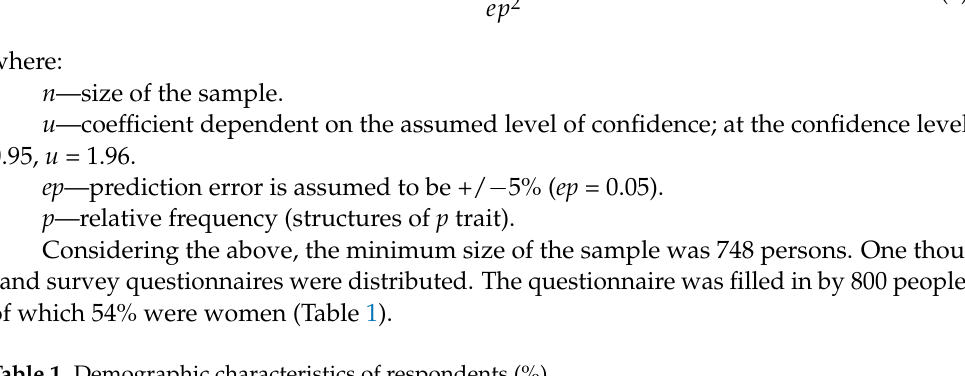
Table 1. Demographic characteristics of respondents